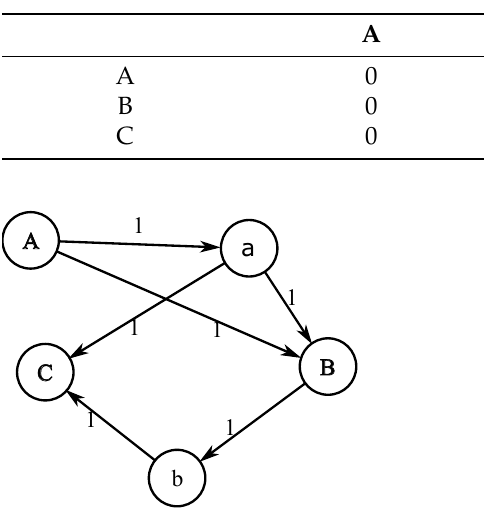
Table 6. Key function call table.